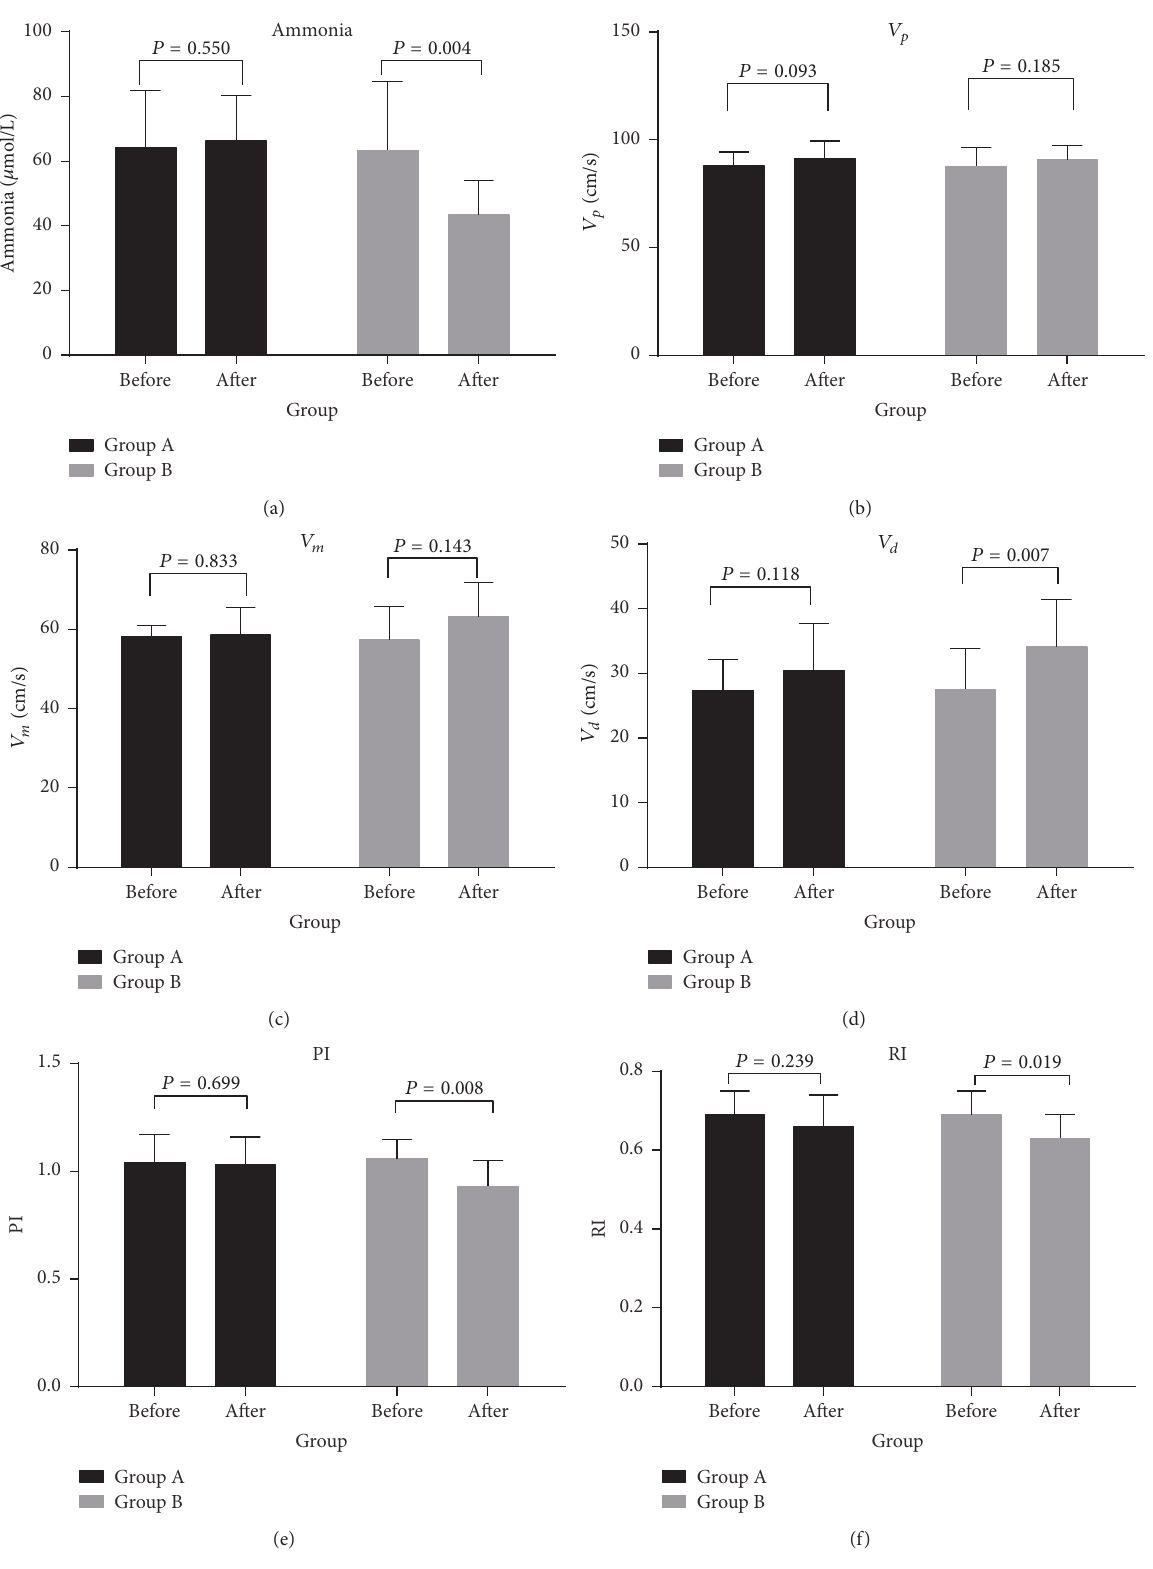
Figure 2: Comparison of ammonia and TCD before and after treatment in groups A and B . It includes the subfigures (a, b, c, d, e, and f). Subfigure (a) is comparison of ammonia. Subfigure (b) is comparison of 𝑉 𝑝 . Subfigure (c) is comparison of 𝑉 𝑚 . Subfigure (d) is comparison of 𝑉 𝑑 . Subfigure (e) is comparison of PI. Subfigure (f) is comparison of RI. Group A is the control group; group B is the treated group. The data were compared using 𝑡 -test. 𝑃 < 0.05 means significant differences in an index among